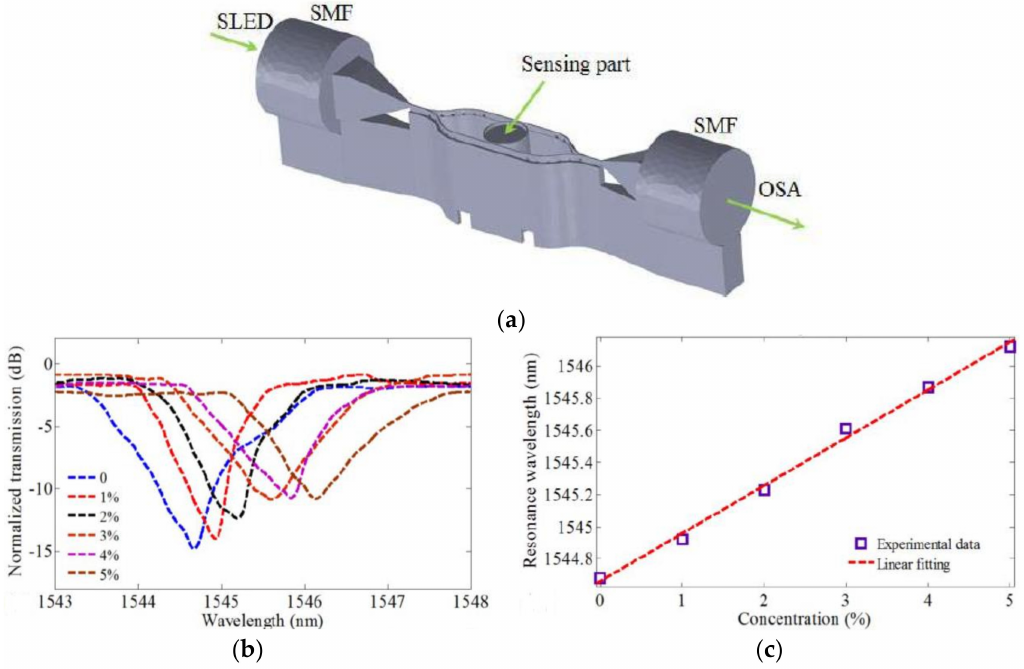
Figure 5. ( a ) Micro-cylinder resonance sensor; ( b ) transmission spectrum of the sensor for different concentrations of NaCl solution; and ( c ) relationship between wavelength in ( b ) and concentration of NaCl solution